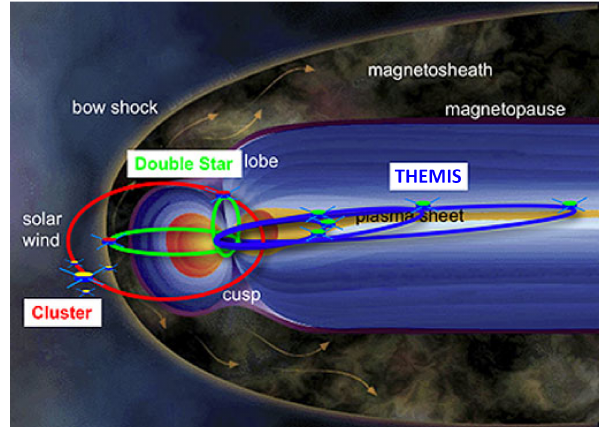
Figure 7. Schematic of the THEMIS mission (credit: